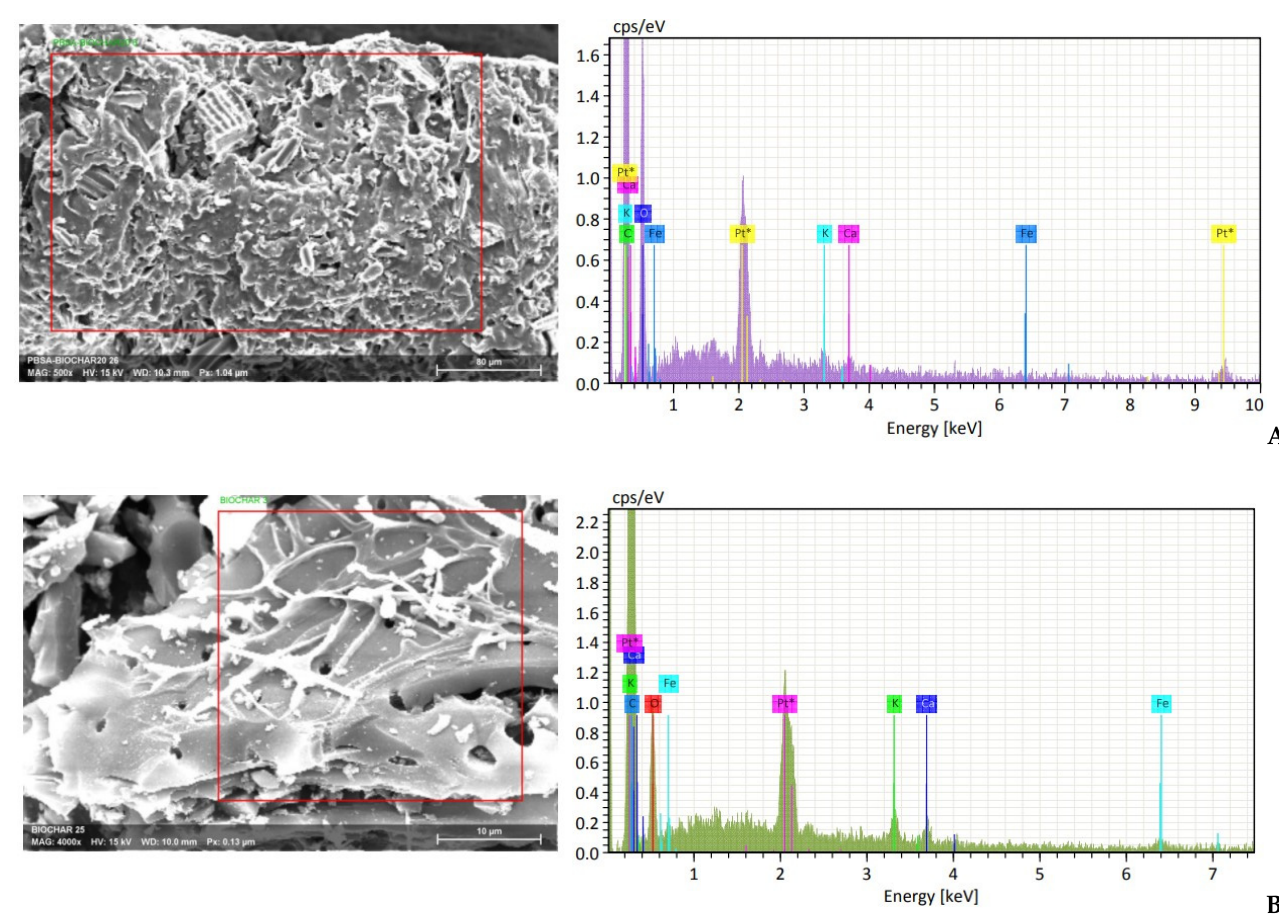
Figure 10 . EDS microanalysis of specific areas on PBSA20 ( A ) and Biochar ( B ). The platinum Pt peak is associated with the sample surface coating.